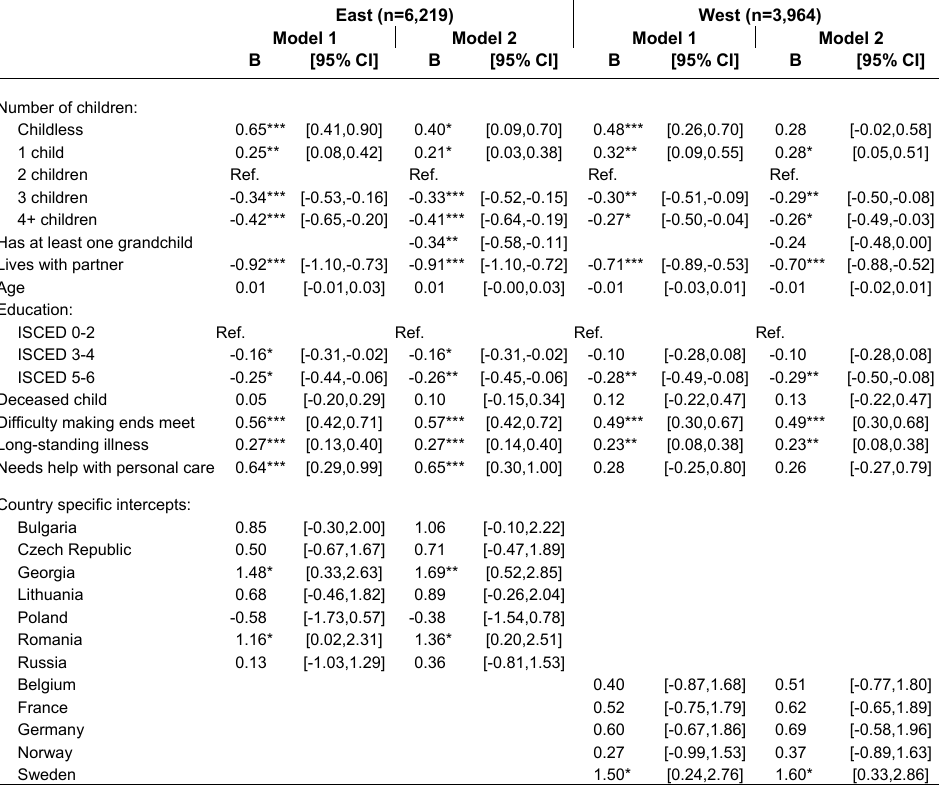
Table 3 : Coefficient estimates from logistic regression models for loneliness among